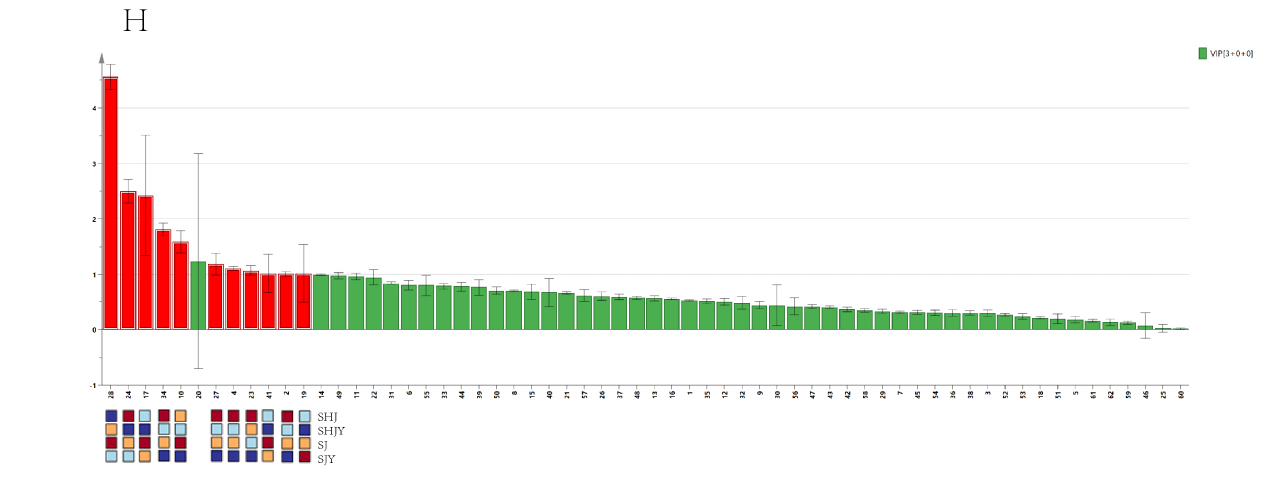
Figure 4. PCA, OPLS-DA, Permutation and VIP of HS-SPME-GC-MS correspond to ( A – C , G ); PCA, OPLS-DA, Permutation and VIP of HS-GC-IMS correspond to ( D – F , H ). (The codes of the compounds correspond to those in Supplementary Table S3).